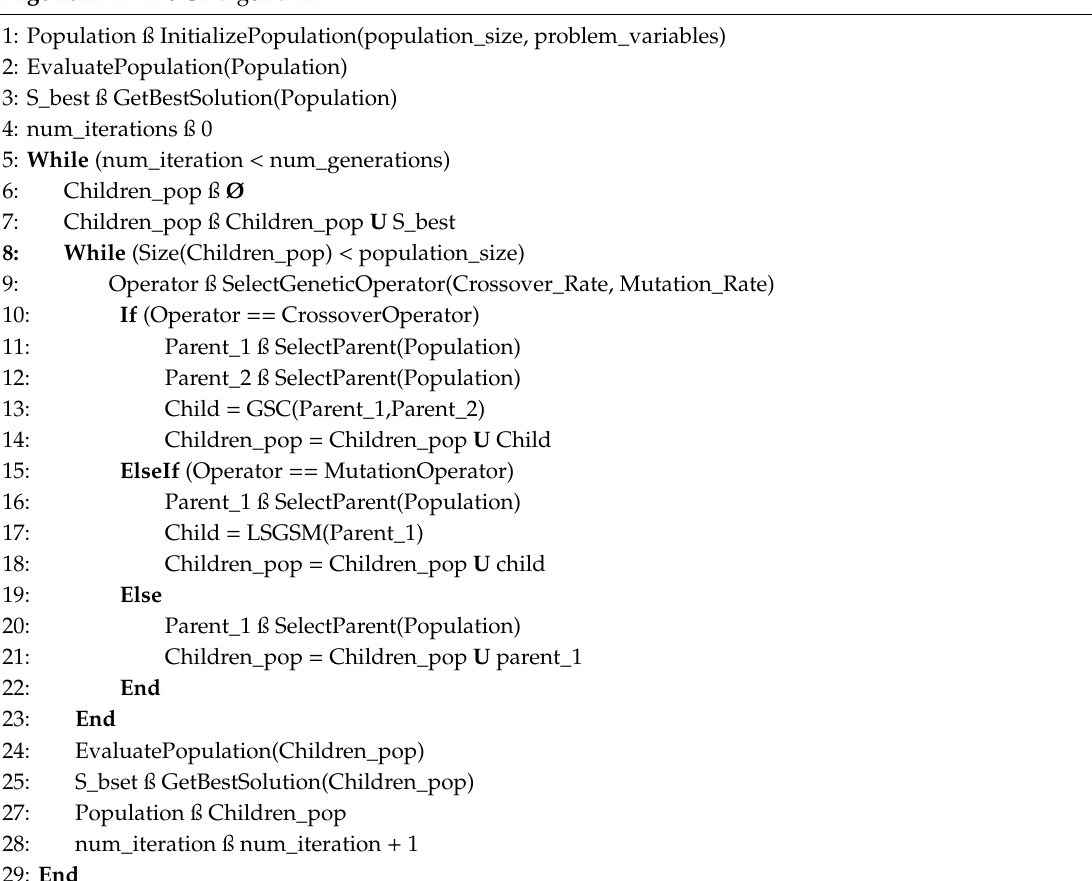
Algorithm 1 : The GP